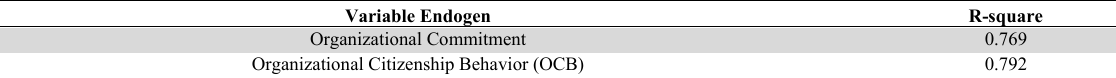
Value of R 2 Variable